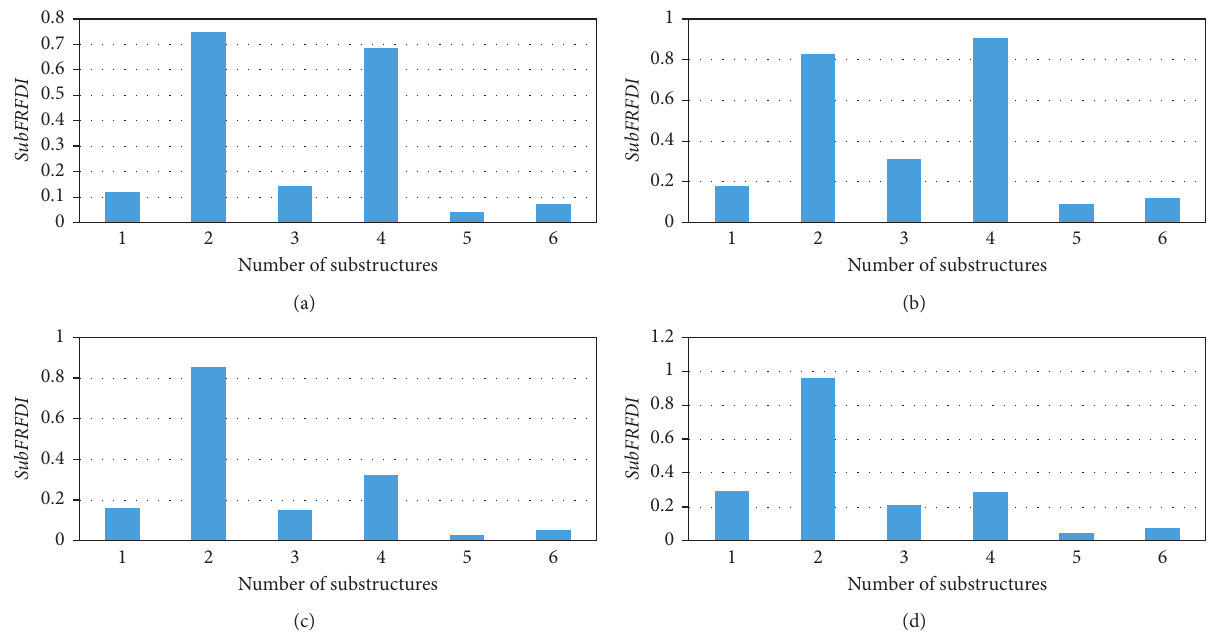
Figure 13: SubFRFDI values for (a) case Dam_2F10%&4F15%, (b) case Dam_2F10%&4F20%, (c) case Dam_2F15%&4F10%, and (d) case Dam_2F20%&4F10%.